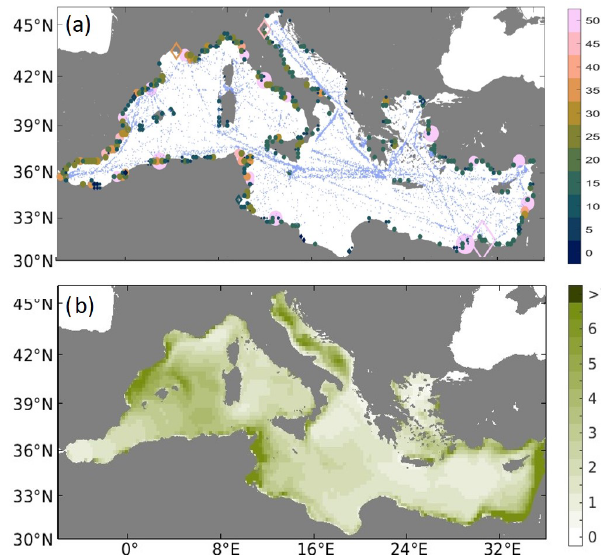
Figure 3. (a) Spatial distribution of initial marine-litter concentra- tions (in kgkm − 2 ) for the three simulations. Filled circle points in- dicate cities, diamonds indicate rivers, and points over the sea indi- cate the shipping lanes. (b) Average marine-litter concentration of neutral particles (kgkm − 2 ) for the period